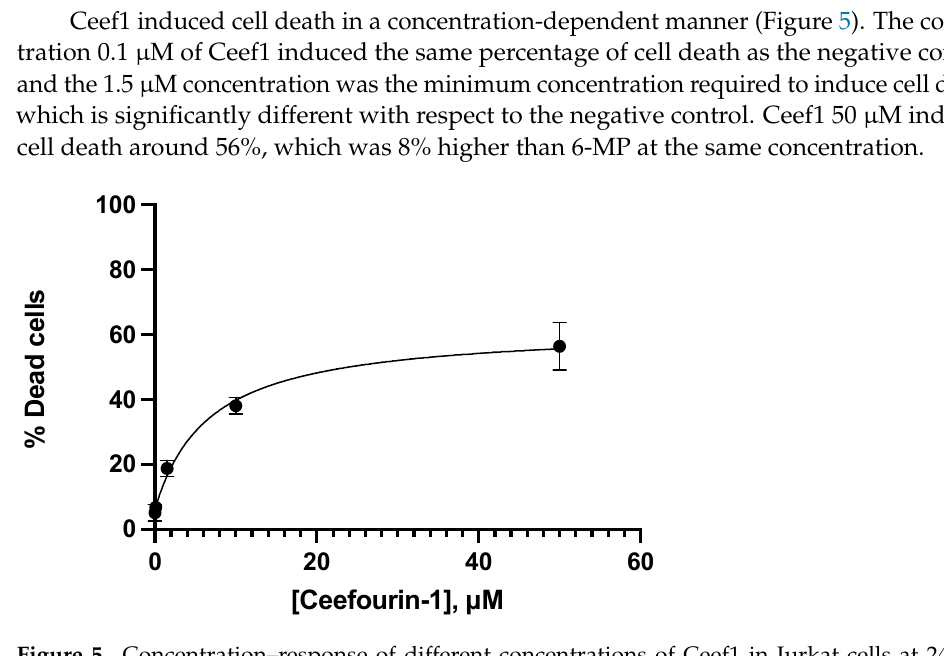
Figure 5. Concentration–response of different concentrations of Ceef1 in Jurkat cells at 24 h of treatment to test cell viability. Mean +/ − SE are shown in each point. Percentage of dead cells were identified by trypan blue.